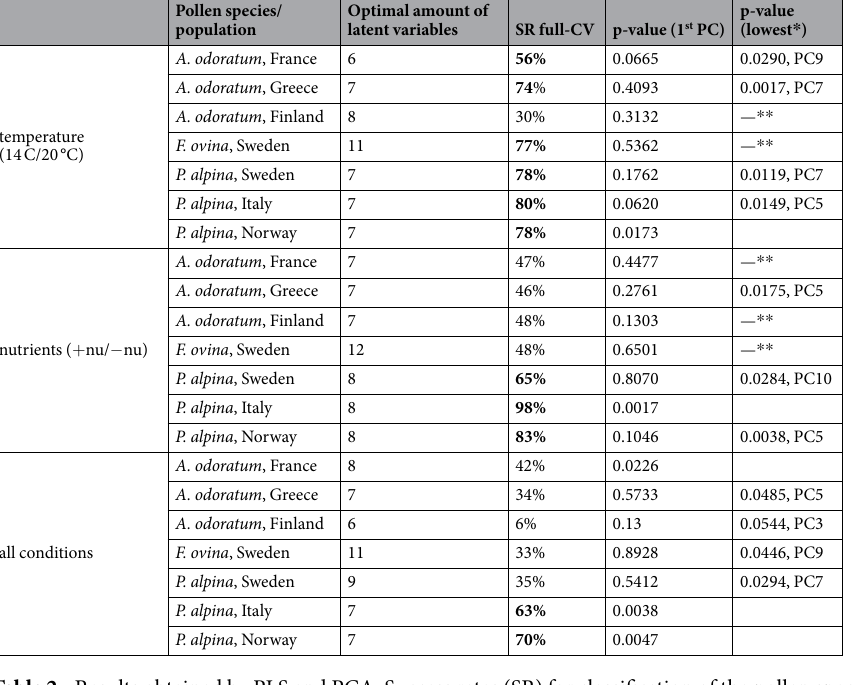
Table 2. Results obtained by PLS and PCA. Success rates (SR) for classification of the pollen spectra from samples of the four cultivation conditions for full cross validation (full-CV) using PLS with the optimal amount of latent variables, as well as p-values of the first principal component calculated using a Kruskal-Wallis test. Analysis was done for different temperatures, nutrient conditions and the combination of both for each population, respectively (sections top to bottom). * Lowest p-value and respective principal component for the 2 nd to 10 th PC. ** No significant p-value could be calculated for the investigated PCs.